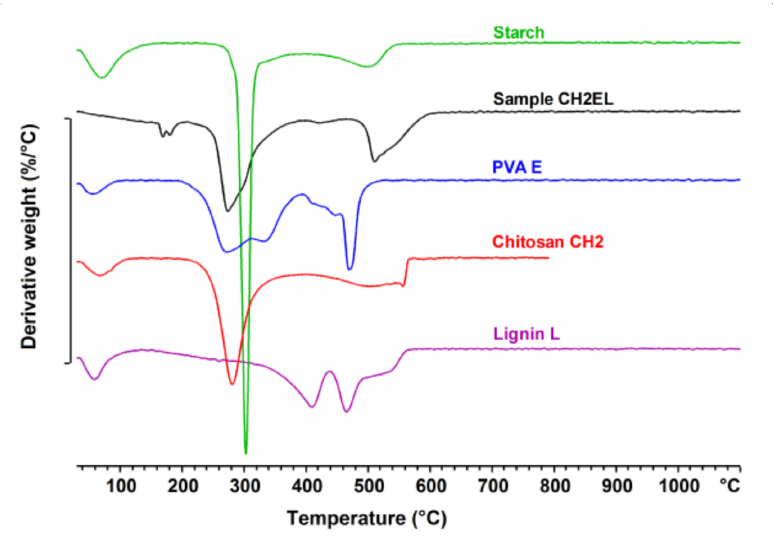
Figure 10. DTG curves of chitosan/starch − based samples.